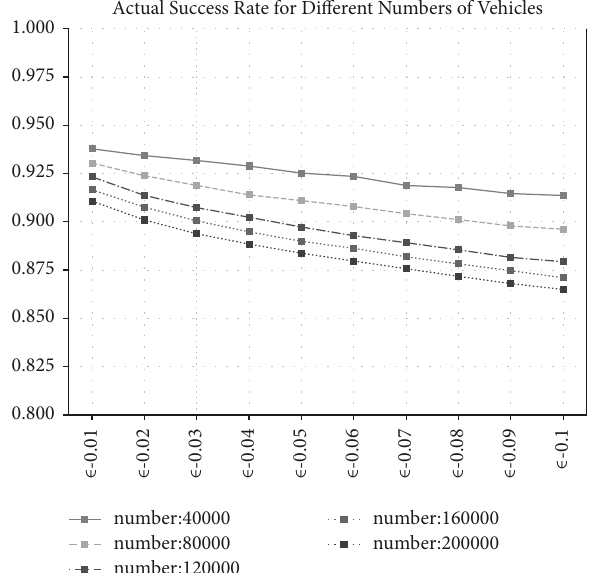
Figure 9: Actual success rate for different numbers of vehicles.